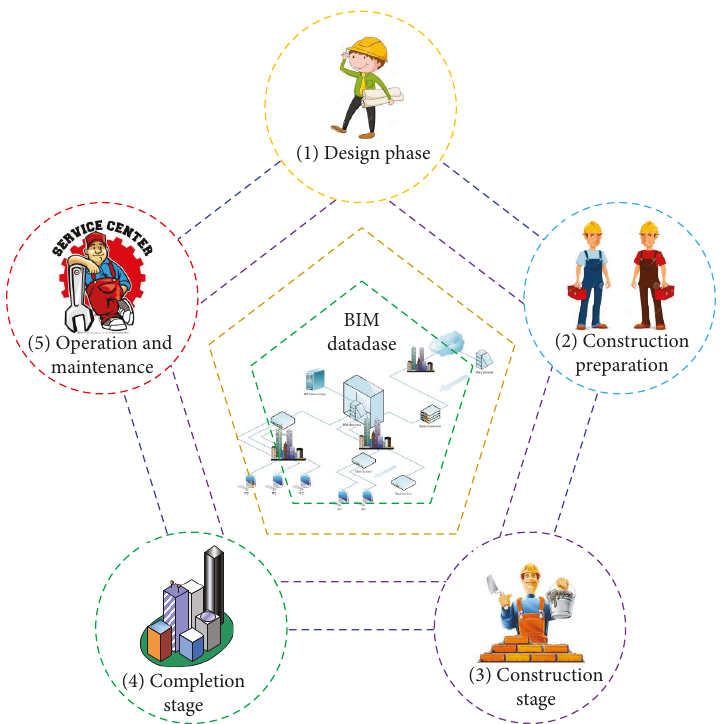
Figure 2: The data source of the BIM